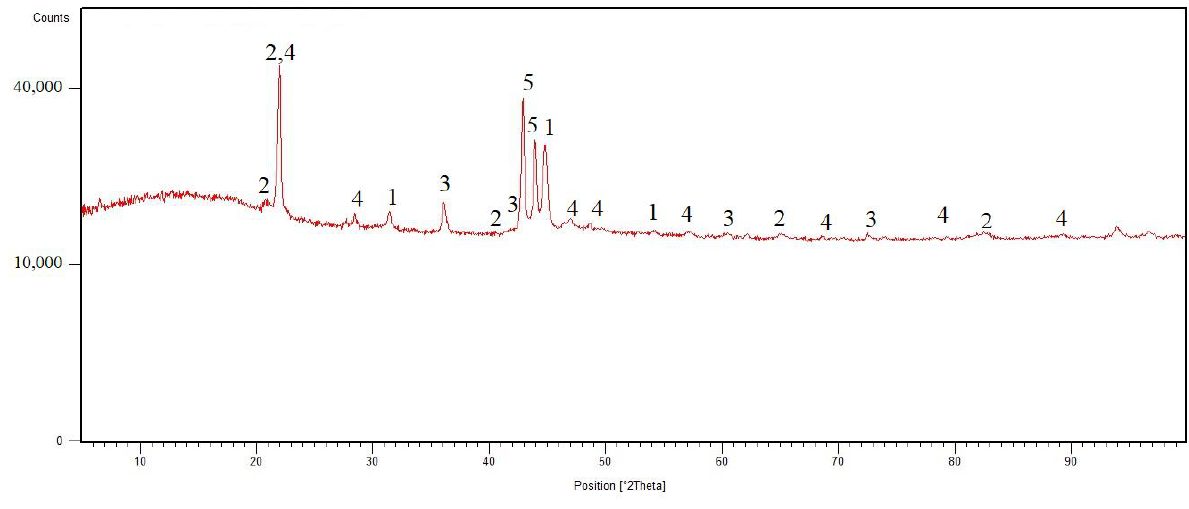
Figure 1. XRD pattern of Co70W12Al15 alloy: 1 — AlCo; 2 — WC; 3 — TiWC 2 ; 4 — SiO 2 ; 5 — C.